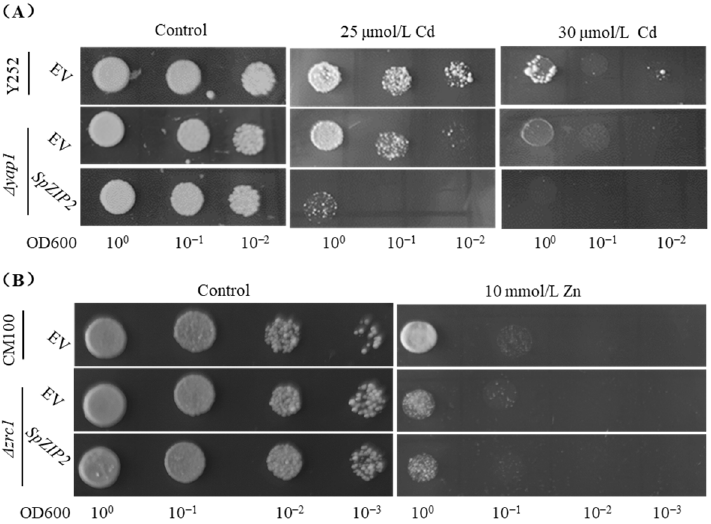
Figure 5. Tolerance of yeast transformants expressing SpZIP2 to Cd or Zn stresses. ( A ) Tolerance of yeast transformants expressing SpZIP2 to Cd stress. ( B ) Tolerance of yeast transformants expressing SpZIP2 to Zn stress.